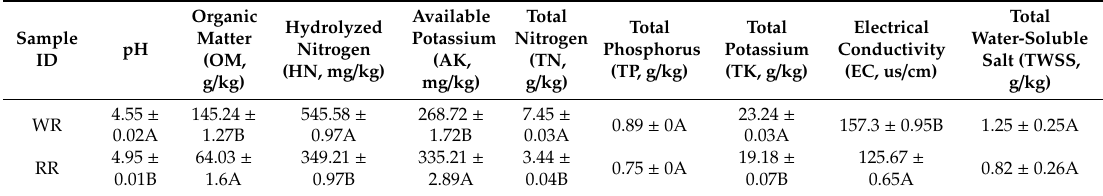
Table 1. Physical and chemical properties of the rhizospheric soil from wild and reintroduced M. sinica. Sample